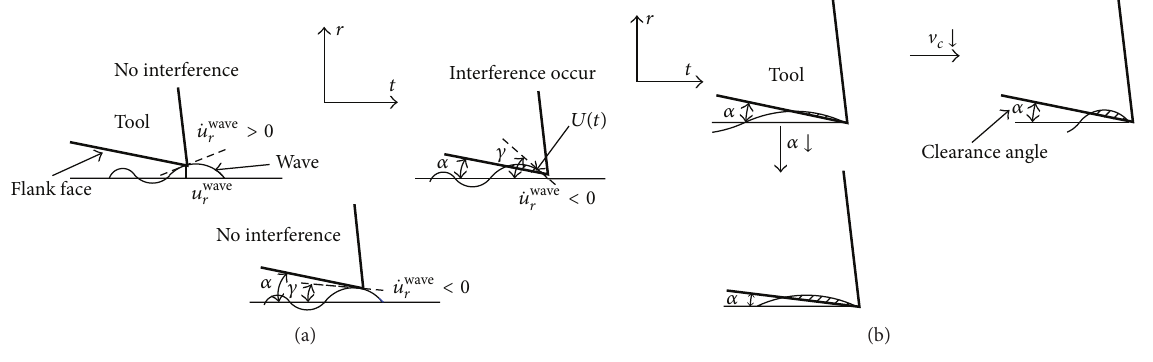
Figure 2: Formation mechanism of indentation area.